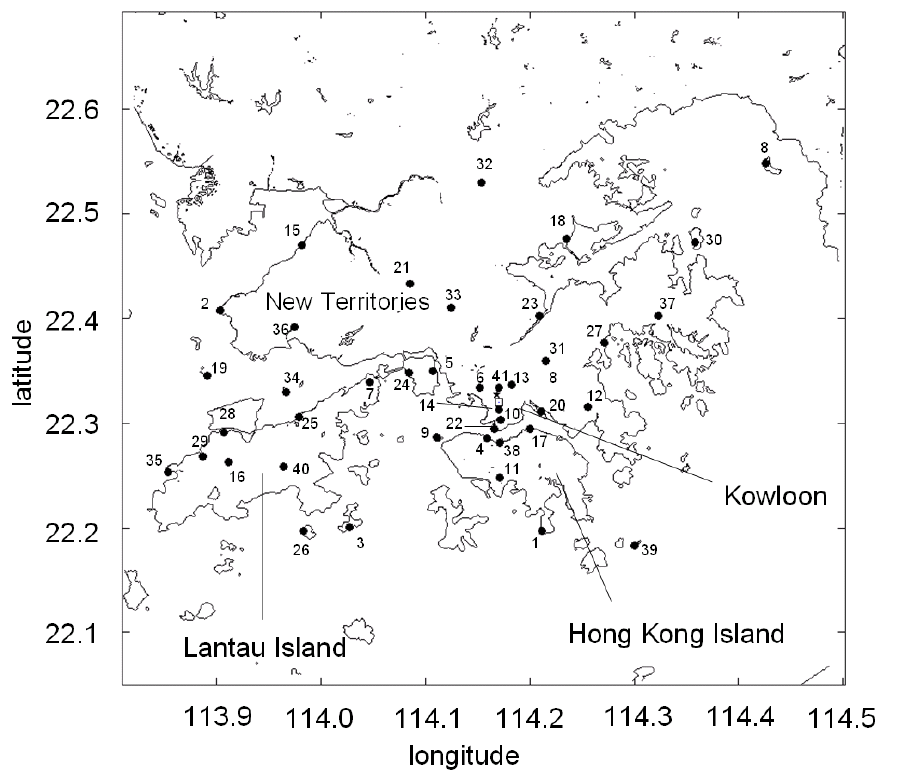
Figure 3. Forty-one meteorological stations operated by the Hong Kong Observatory as indicated by  . The digits represent different stations and their corresponding names of the stations are given in Table 1. The small square (station 14) is the King’s Park upper air sounding station and the small star is the Sham Shui Po wind profiler